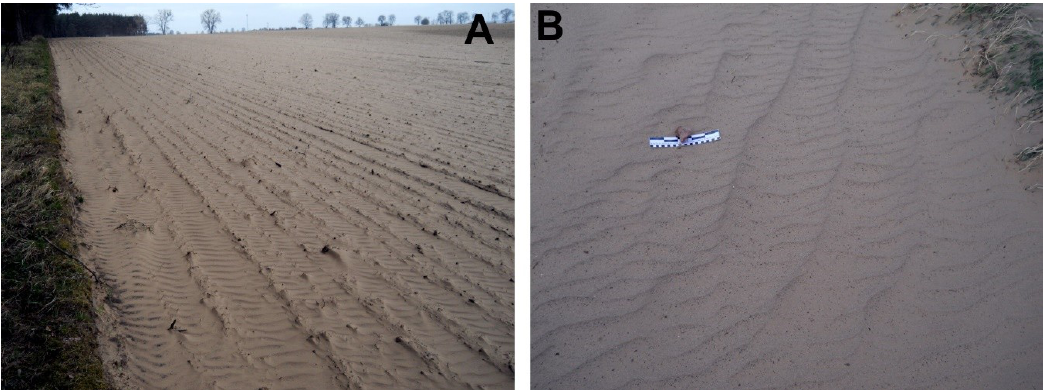
Figure 8. Aeolian accumulative forms in the research fields. ( A , B )—aeolian ripple marks (photos taken on 9 April 2011).